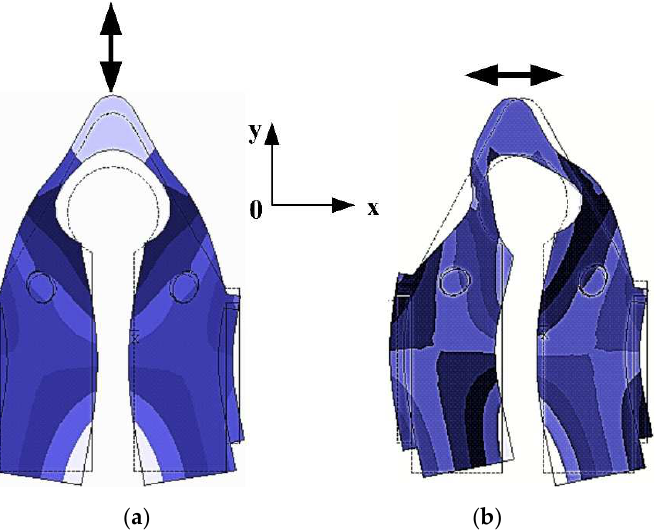
Figure 2. Flexural mode of the stator with patch structure: ( a ) Symmetrical flexural mode; ( b ) Anti-symmetric flexural mode.